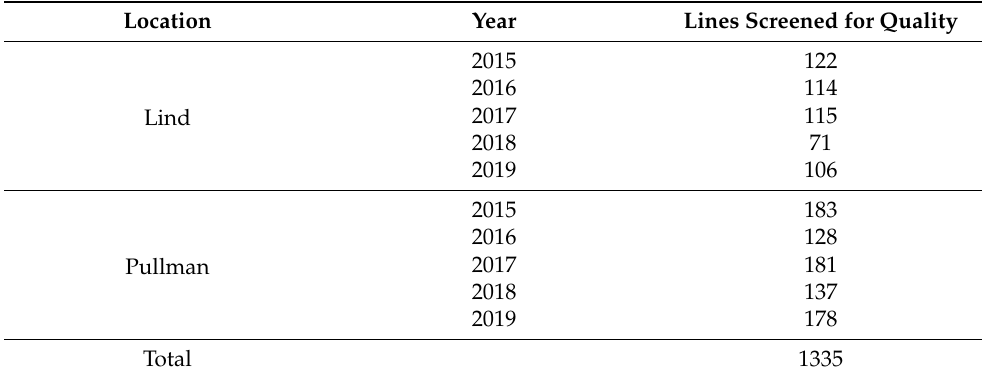
Table 1. Total number of lines screened across each year at two locations in Washington and phenotyped for end-use quality traits.